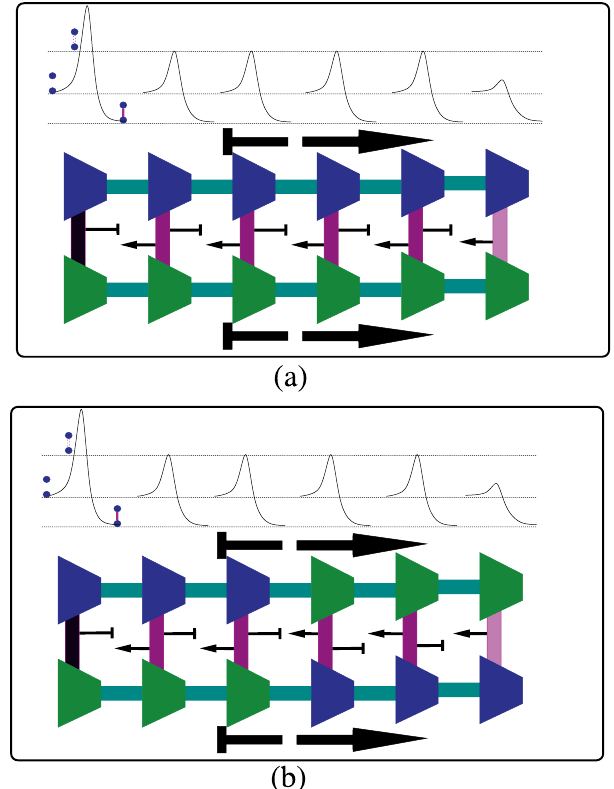
Figure 5. Illustration of the relative ineffectiveness of sequence variations in influencing unzipping kinetics in hypothetical parallel-stranded DNA-like molecule. The kinetic barriers for the interstrand hydrogen bonds, shown above the strand diagrams, can be seen to be similar in ( a , b ), irrespective of the difference in their sequences. Again, the color of the hydrogen bonds represent the height of the kinetic barrier separating bonded and unbonded configurations, higher the barrier, darker the color. This has to be contrasted with the substantially different kinetic barrier profiles between ( a , b ) of Fig. 3. The reason for the lack of influence of sequence on the kinetic barriers in the hypothetical parallel-stranded DNA-like molecule is because of the additive influence of sequence-independent asymmetric cooperativity of the two strands, which overwhelms the variations in kinetic barriers arising from the sequence-dependent part. Due to the cancellation of sequence-independent asymmetric cooperativity in anti-parallel double strand DNA, variations in the sequence results in strong variations in the kinetic barriers of interstrand hydrogen bonds. The unzipping kinetics of the anti-parallel DNA thus becomes intimately linked with its sequence, providing a crucial, additional degree of